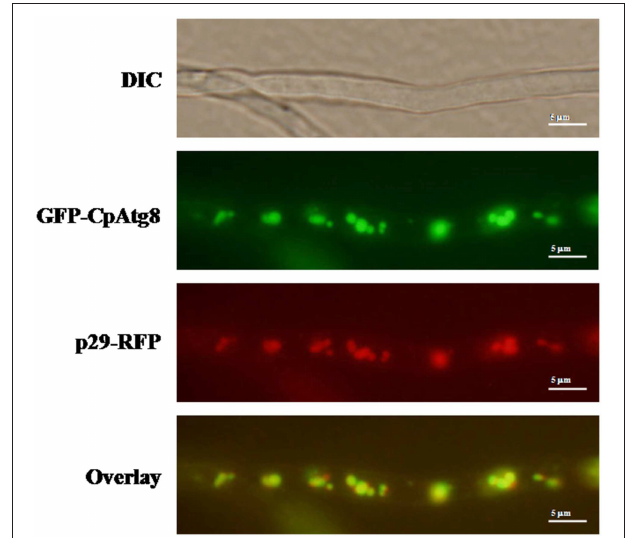
FIGURE 8 | Localization of p29-RFP and GFP-CpATG8 under normal growth conditions. The strain expressing p29-RFP and GFP-CpATG8 was grown on PDA medium. After 7 days, hyphae were observed by DIC and fluorescence microscopy. Scale bars, 5 µ m. vacuoles of the strain DK80 were seen by transmission electron microscopy, but not in the cpatg8 mutant ( Figure 5B ), suggesting that cpatg8 is a gene essential for autophagy in C. parasitica